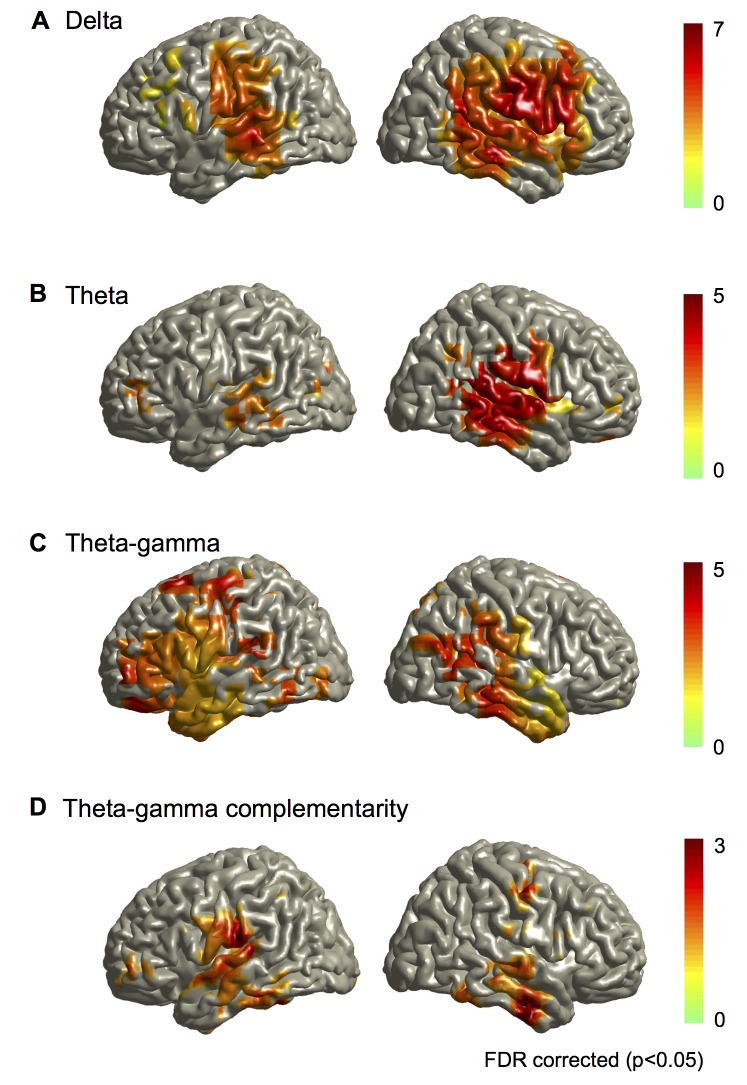
Mutual information group statistics.All statistical maps are thresholded at p = 0.05 (FDR corrected) and colourbars show t-values. (A) Group statistical map of MI between speech phase and phase of brain activity in the delta frequency band (1–3 Hz) for the statistical contrast story versus back (see Figure S1 for corresponding map using PLV). (B) Group statistical map of MI between speech phase and phase of brain activity in the theta frequency band (3–7 Hz) for the statistical contrast story versus back (see Figure S1 for corresponding map using surrogate data). (C) Group statistical map of MI between 3–7 Hz theta phase in speech signal and 35–45 Hz gamma amplitude in brain activity for the contrast story versus back. (D) Complementarity between theta phase and gamma amplitude. Mutual information between theta phase in speech and theta phase in brain activity was computed with and without corresponding gamma amplitude signal. The statistical map shows significantly increased MI when gamma amplitude is used in addition to theta phase.